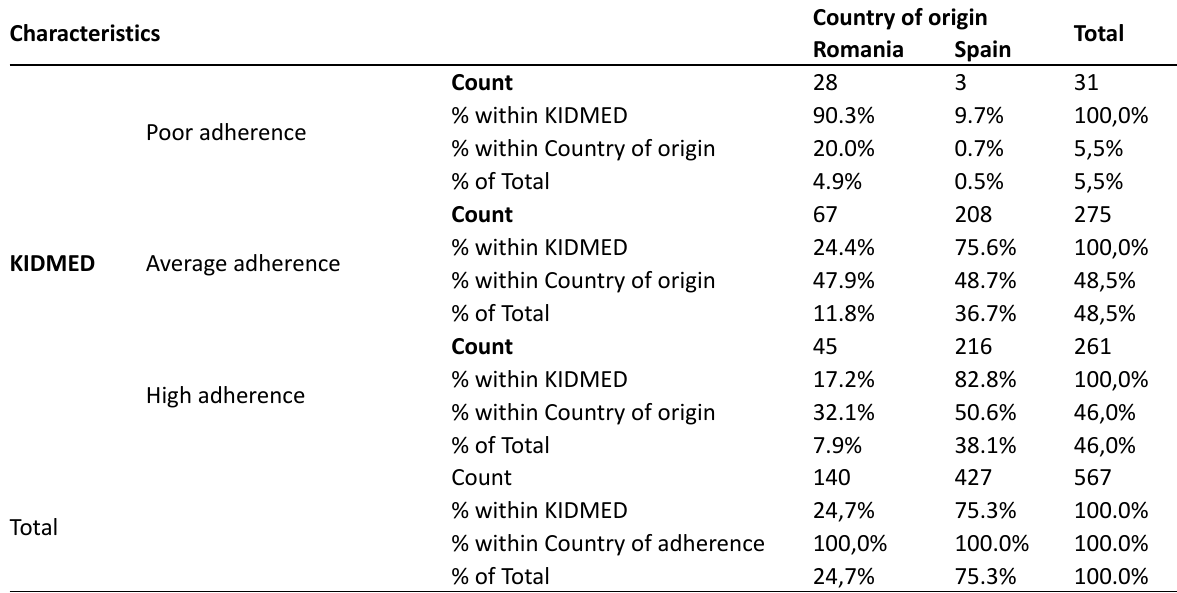
Table 2. KIDMED depending on the country of origin Characteristics